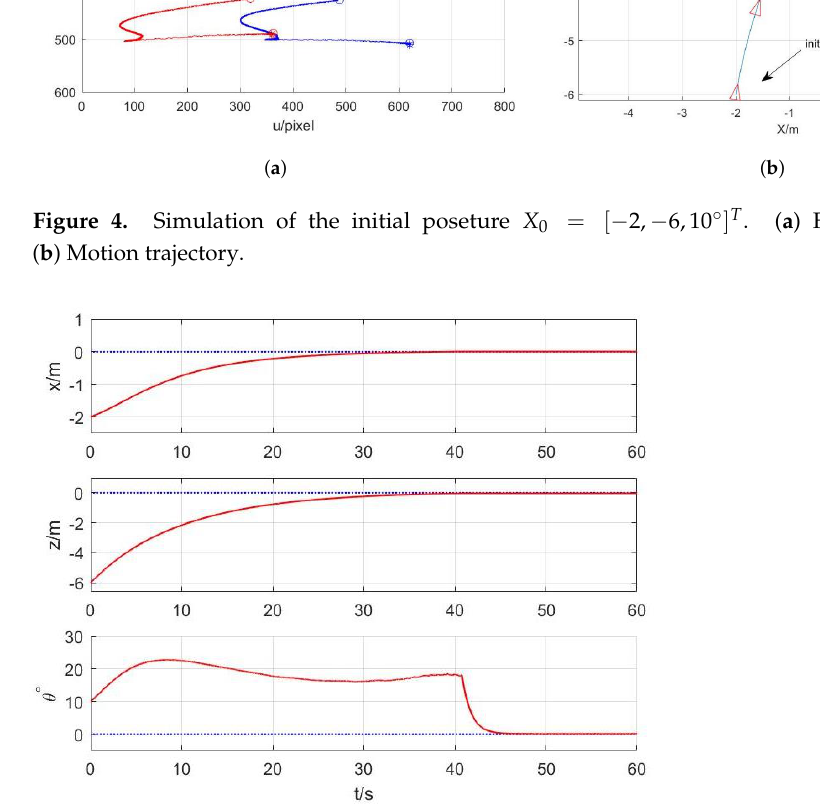
Figure 5. Simulation of the initial pose X 0 = [ − 2, − 6,10 ◦ ] T : Evolution of the mobile robot pose and the stage